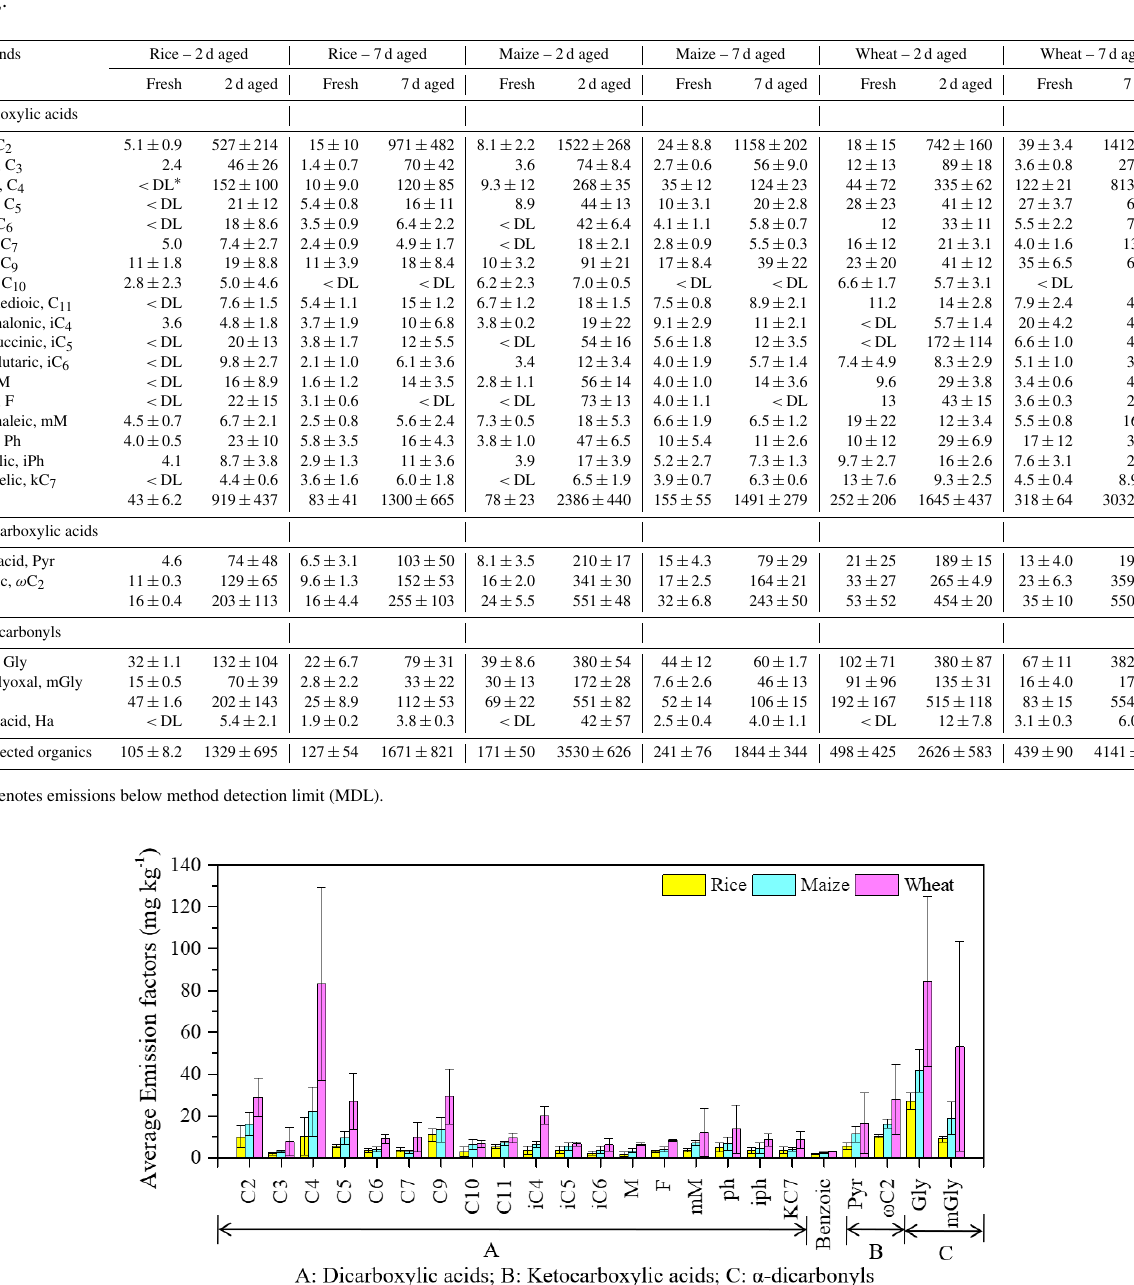
The decreases in of (cid:54) VOC EF after 2 d aging (1227 mg kg − 1 ) were comparable with those of 7 d aging (884 mg kg − 1 ) for maize straw (Niu et al.,